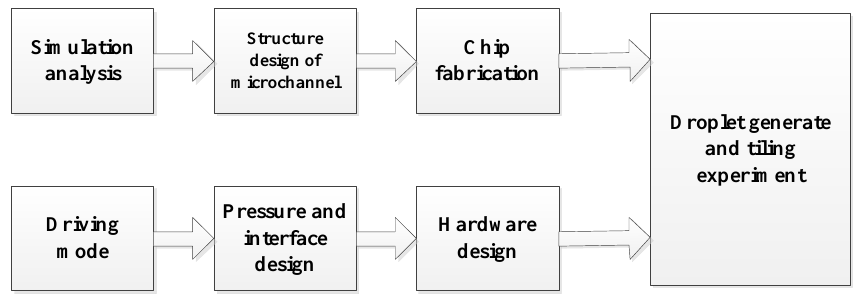
Figure 1. Research route of droplet generation and validation experiment.